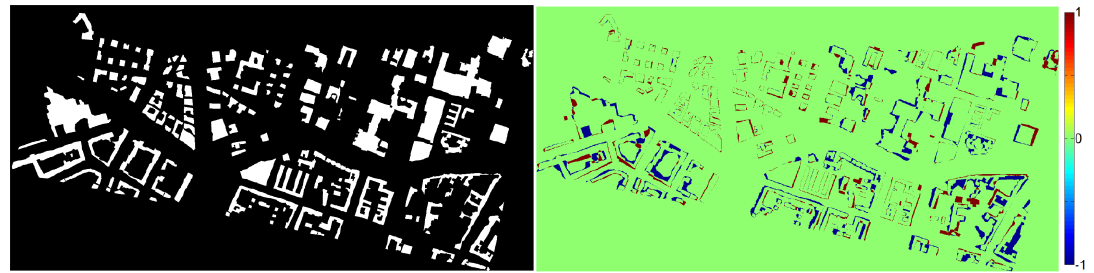
Figure 4: Common (left) and difference (right) images computed using reference footprint image and final reconstructed footprints. The difference image is computed by subtracting the final reconstructed footprints image from the reference footprints